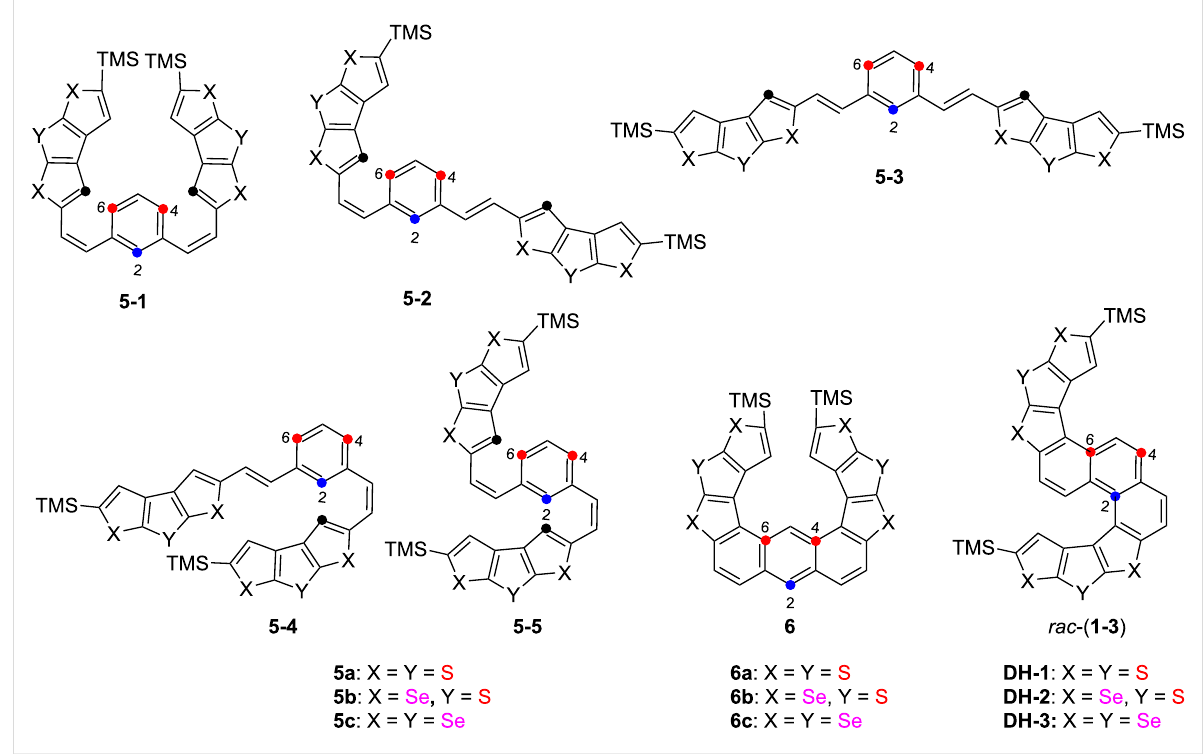
Figure 2: Five kinds of isomer structures of 5 and two kinds of possible oxidative photocyclization product structures of 6 and DH - 1 – 3